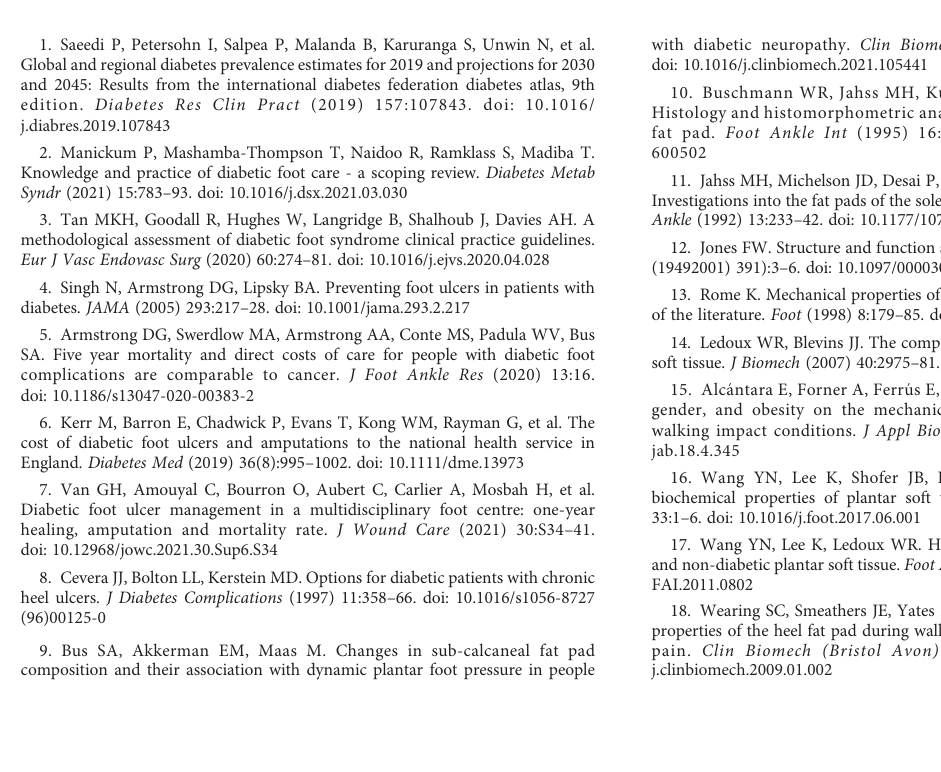
SUPPLEMENTARY FIGURE 1 Paired box plot comparing the material properties between left and right foots, before (A – F) and after (G – L) continuous loading.##, the difference between two loading statuses follow the normal distribution; $$, the difference between two loading statuses didn ’ t follow the normal distribution; “ t ” and “ w ” represent the statistical effect sizes for paired-T test, and paired-Wilcoxon test, respectively. EDR, energy dissipation rate. SUPPLEMENTARY FIGURE 2 The correlation matrix for duration of diabetes history, BMI, age, primary thickness, peak strain, peak stress, stiffness, viscous modulus, and EDR of heel in diabetes subjects at time zero. The values displayed in the right- upper triangle represent the Pearson ’ s correlation coef fi cients (R values). The lower-left triangle displays the scatter plots and regression lines. The plots on the diagonal line present the distribution density of the variables in the matrix. BMI: body mass index; EDR, energy dissipation rate. P values:.p<0.100, *p<0.050, **p<0.010, ***p<0.001. SUPPLEMENTARY FIGURE 3 The correlation matrix for duration of diabetes history, BMI, age, primary thickness, peak strain, peak stress, stiffness, viscous modulus, and EDR of heel in diabetes subjects following continuous loading. The values displayed in the right-uppertrianglerepresentthePearson ’ scorrelationcoef fi cients(Rvalues). Thelower-lefttriangledisplaysthescatterplotsandregressionlines.Theplots on the diagonal line present the distribution density of the variables in the matrix. BMI: body mass index; EDR, energy dissipation rate. P values:.p<0.100, *p<0.050, **p<0.010,